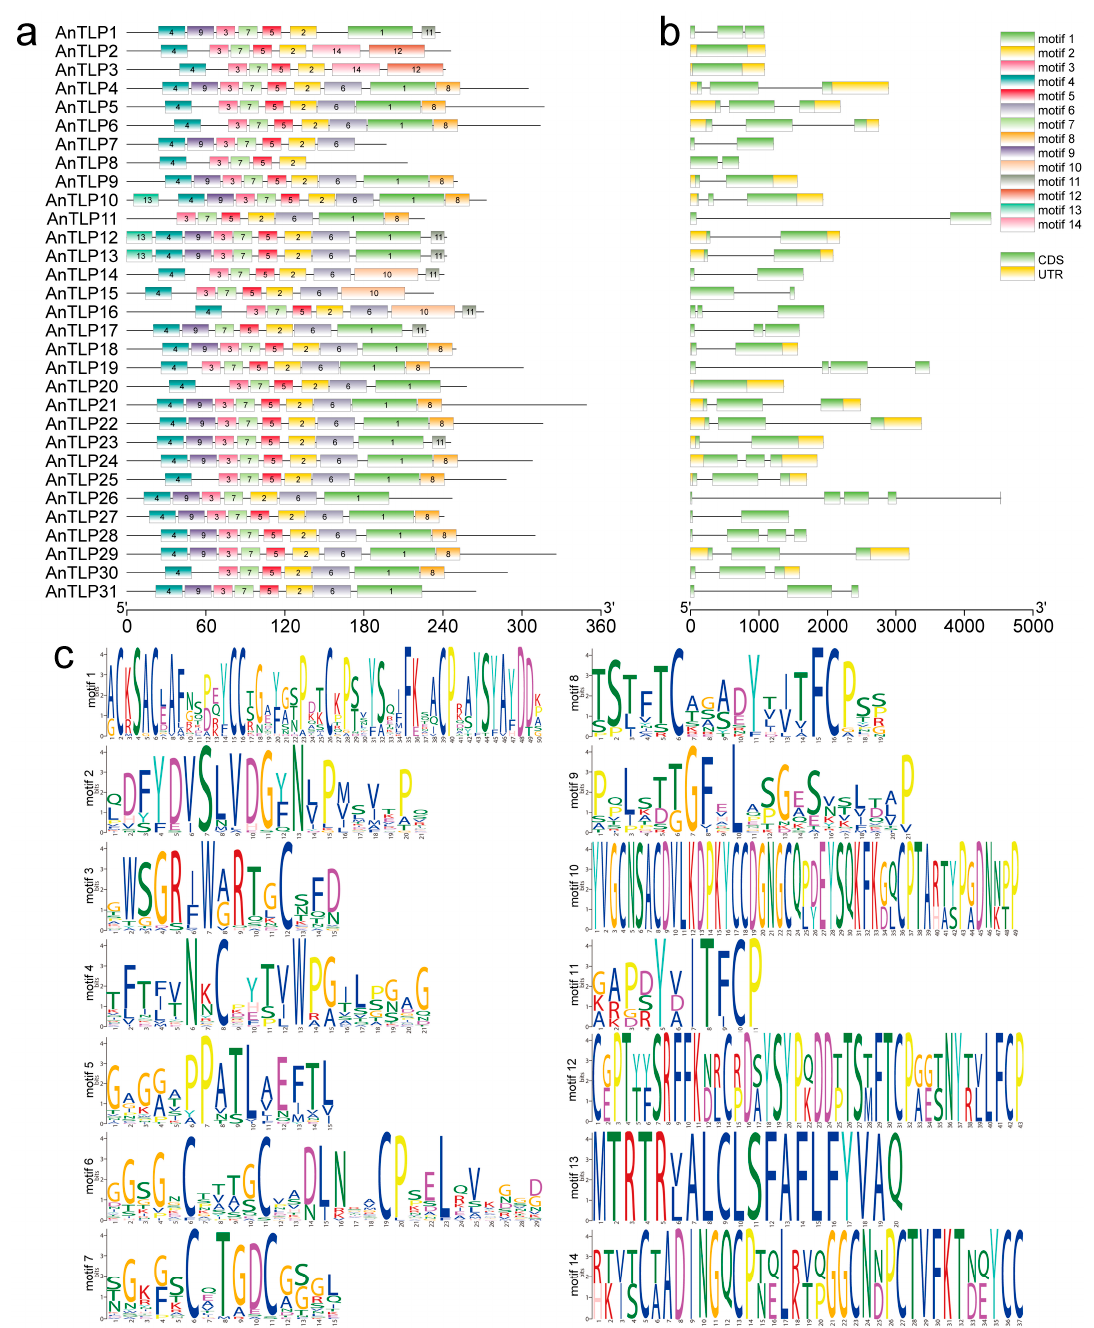
Figure 3. Conserved motif and gene structure of TLP gene family in A. nanus . ( a ) The conserved motif analysis of the TLP family of A. nanus . All motifs were identified using the MEME database. The rectangular box represents the motif, and different colors represent different motifs. The lengths of the proteins and motifs can be estimated using the scale at the bottom. ( b ) The intro–exon structure of the TLP gene family. Black lines represent introns, yellow rectangles represent CDS, and green rectangles represent untranslated regions (UTRs). The size of exons and introns can be estimated using the scale at the bottom. ( c ) Motif sequence logo graph. The relative size of the letters represents their frequency in the sequence. The height of each letter is proportional to the frequency of occurrence of the corresponding base at that